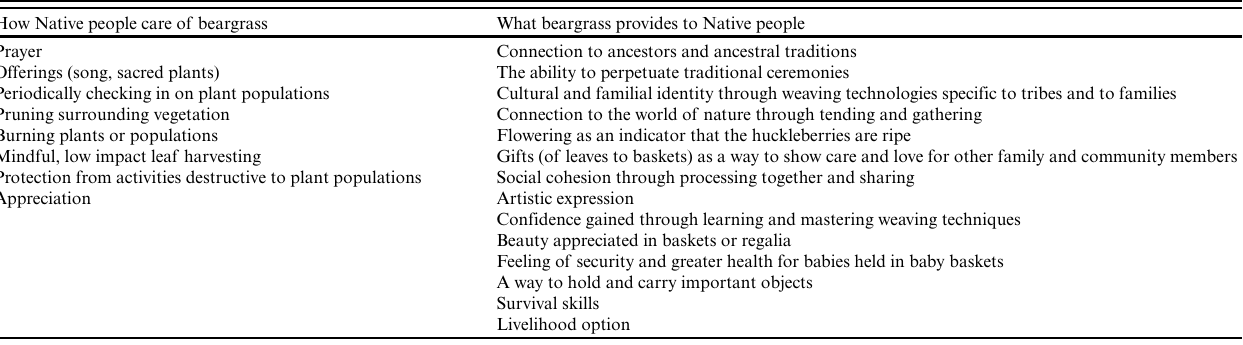
Table 1. Reciprocity within beargrass